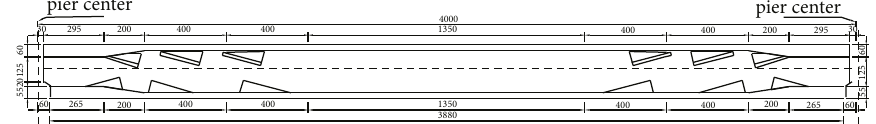
Figure 1: Longitudinal section of 40 m box girder (cm).